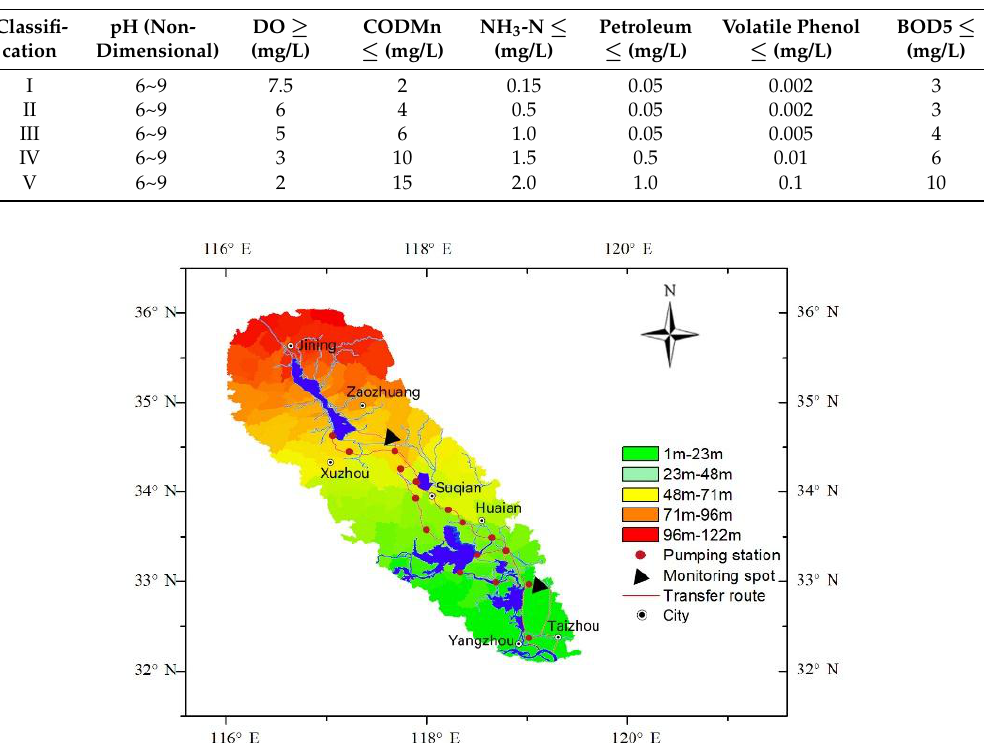
Figure 1. Experimental area in Jiangsu Province.